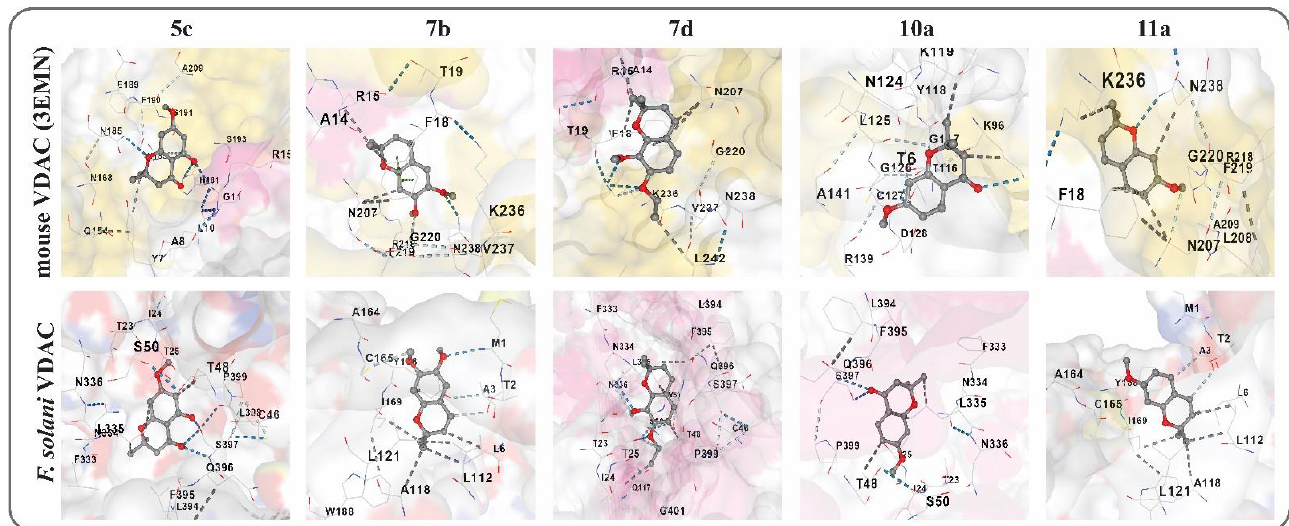
Figure 2. Molecular docking 3D binding models of the tested compounds against voltage-dependent anion channels (VDACs) encoded by mouse and F. solani .